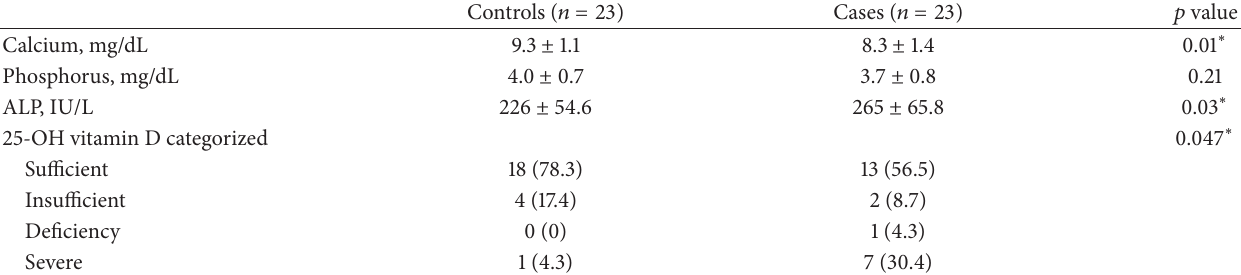
Table 3: Vitamin D status and serum calcium, phosphorus, and alkaline phosphatase levels.